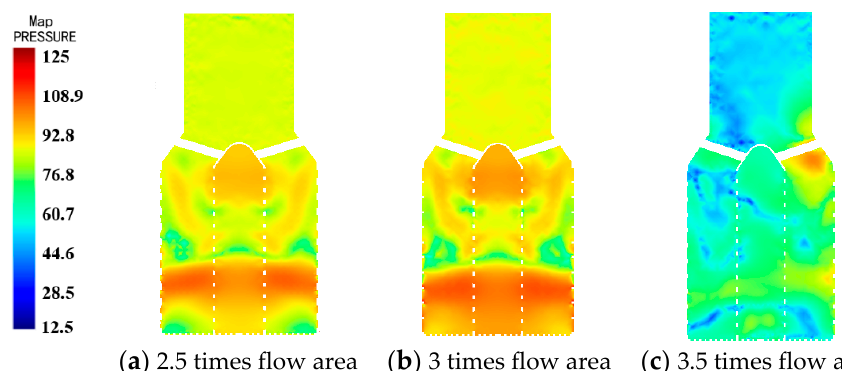
Figure 29. Sound pressure level distribution of different schemes at the first peak.